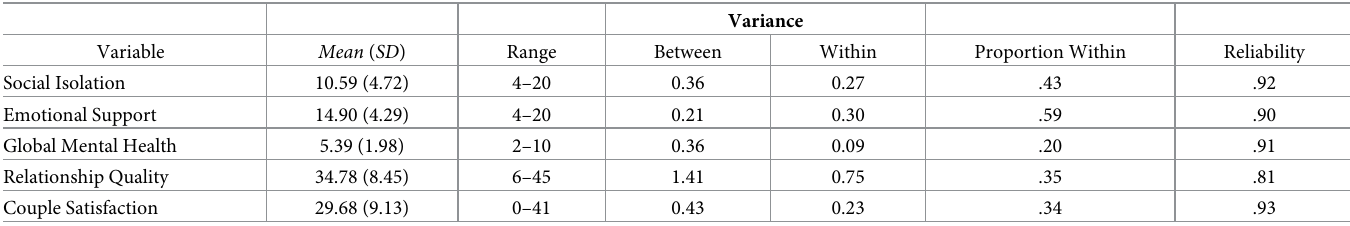
Table 2. Descriptive and inferential